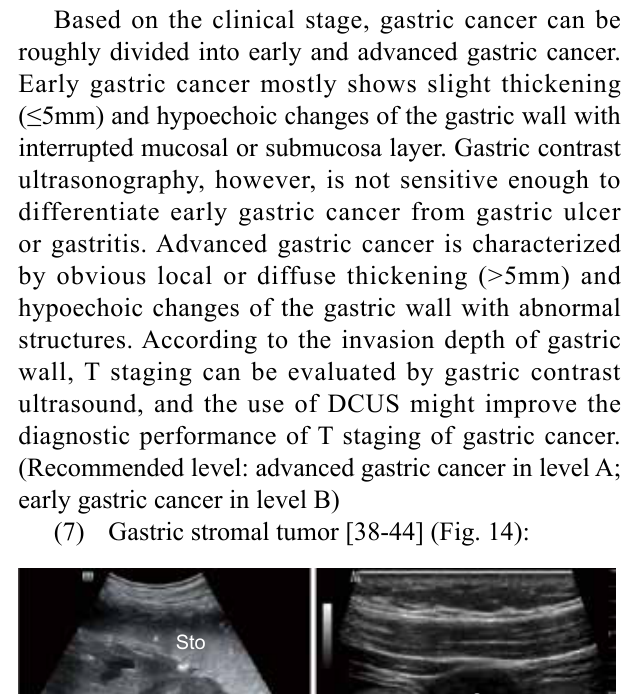
Sto Figure15 Other gastric protuberant lesions shown on contrast ultrasound imaging. (A) Gastric lymphoma; (B) Heterotopic pancreas; (C) Neuroendocrine tumor; (D) Lipoma. Ly, lymphoma; Vp, Heterotopic pancreas; Nc, Neuroendocrine tumor; Li, lipoma. Sto Sto VvVv A B Figure 16 Contrast ultrasound imaging shown gastric varices. (A) Gray- scale image; (B) CDFI image. Sto, stomach; Vv, varices.